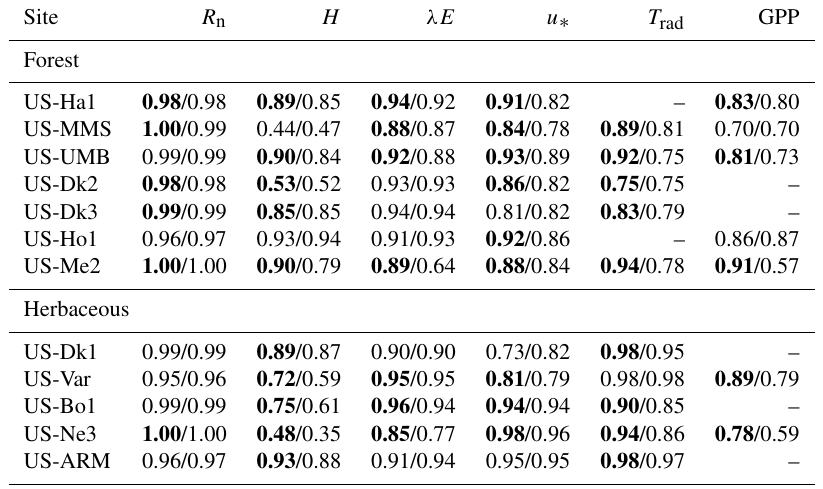
Table 5. Average Taylor skill score for the ML + RSL (first number) and CLM4.5 (second number) simulations. Skill scores greater than those of CLM4.5 are highlighted in bold. GPP: gross primary